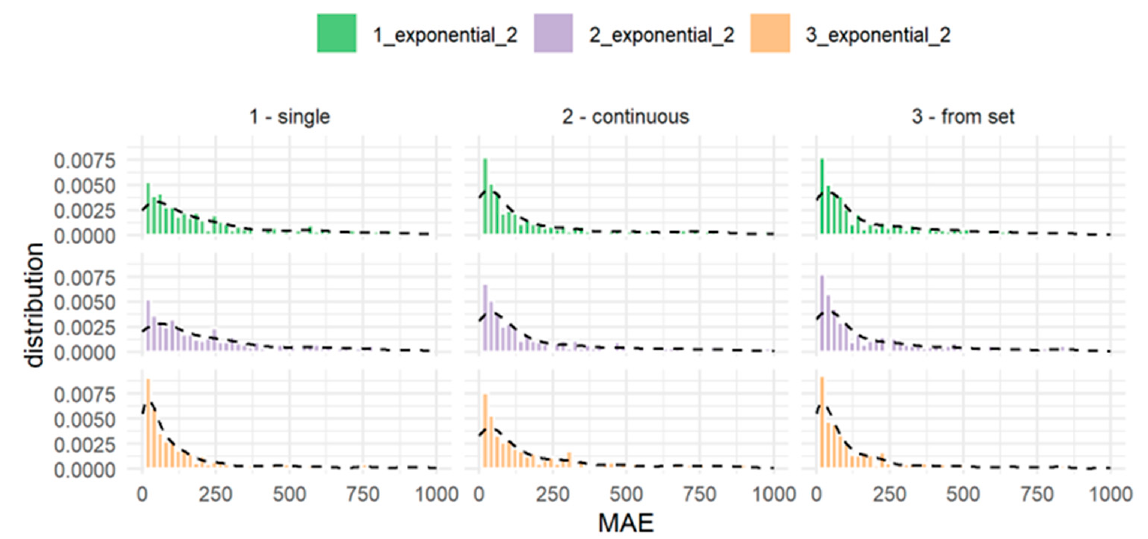
Figure 9. MAE error distribution. Source: own elaboration. Tables 2–7 show detailed statistics for errors MAPE and MAE for the three methods of generating missing values. Table 2. MAPE statistics for the first set of missing data (1—single).